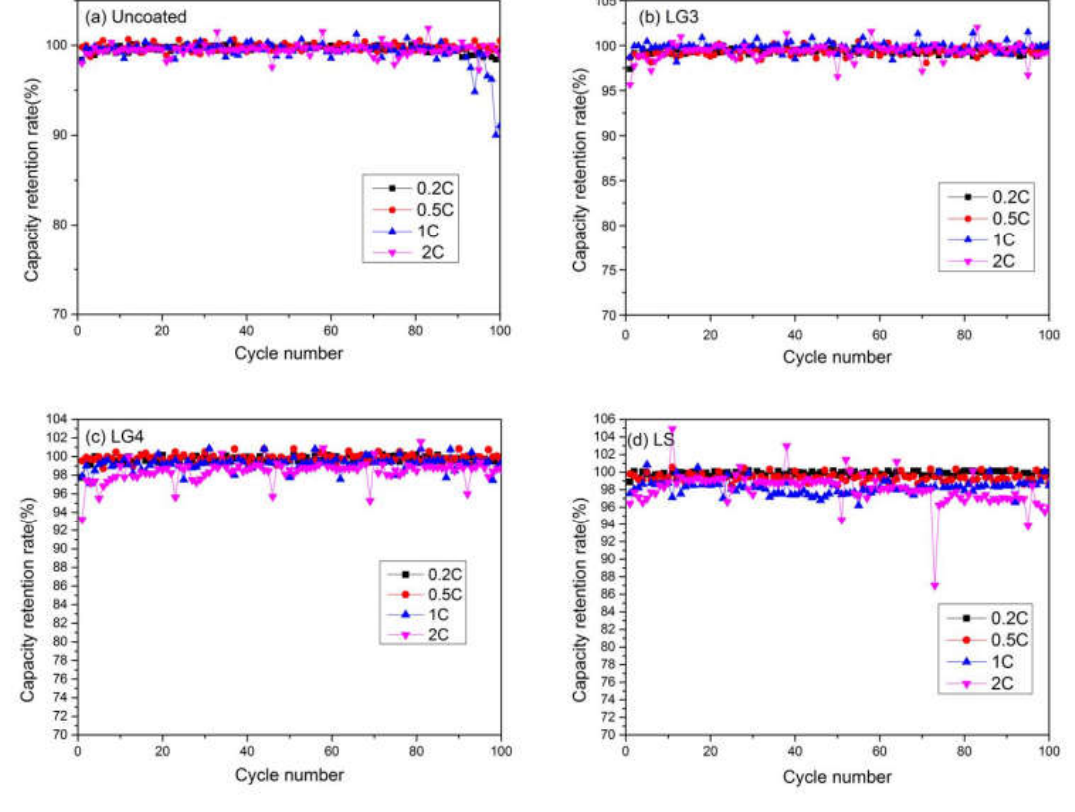
Figure 12. The capacity retention rate of assembled lithium batteries at different discharge rates. ( a ) shows the capacity retention rate of lithium battery at different discharge rates when the lithium battery separator was not coated without any polymer particle adhesives; ( b ) shows the capacity retention rate of lithium battery LG3 at different discharge rates when the lithium battery separator was coated with polymer particle adhesive G3; ( c ) shows the capacity retention rate of lithium battery LG4 at different discharge rates when the lithium battery separator was coated with polymer particle adhesive G4; ( d ) shows the capacity retention rate of lithium battery LS at different discharge rates when the lithium battery separator was coated with polymer particle adhesive S-1.